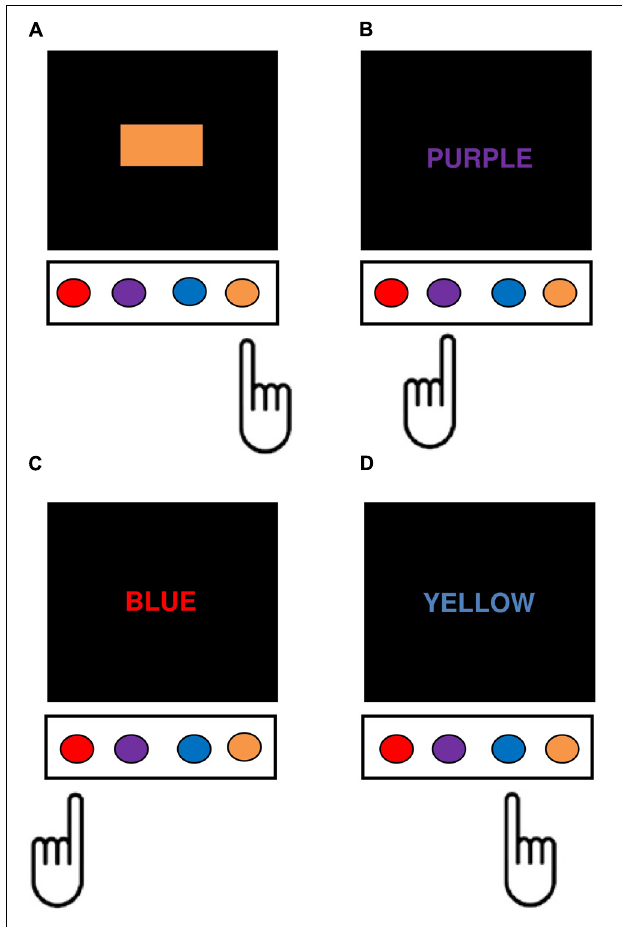
FIGURE 2 | Depiction of the four main task conditions in the modified Stroop Task. In each condition, participants responded manually to the color identity of the task-relevant stimulus dimension by pushing the corresponding computer key. (A) Control (color identification) trials – participants responded to the color of the patches. (B) Congruent trials – participants responded to the text color, which corresponds semantically with the color word. (C) Incongruent response eligible – participants were required to ignore the color word and respond to the text color, which was mapped onto a conflicting manual response. (D) Incongruent response ineligible – participants were required to ignore the color word, which had no corresponding response, and instead respond to the text color in which the word was